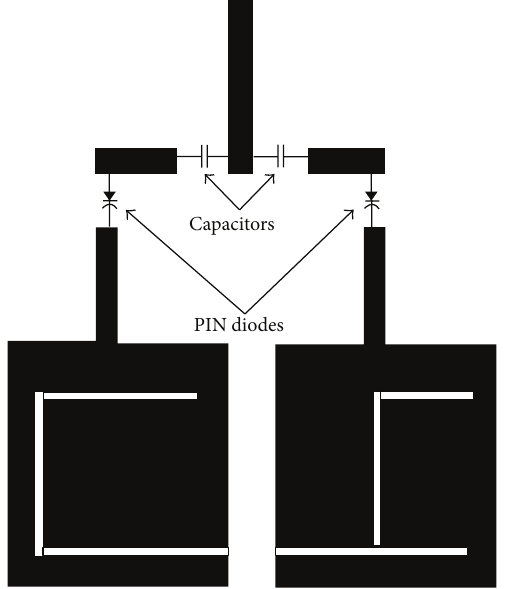
Figure 3: A proposed sensing and communicating antenna config- uration in [7].